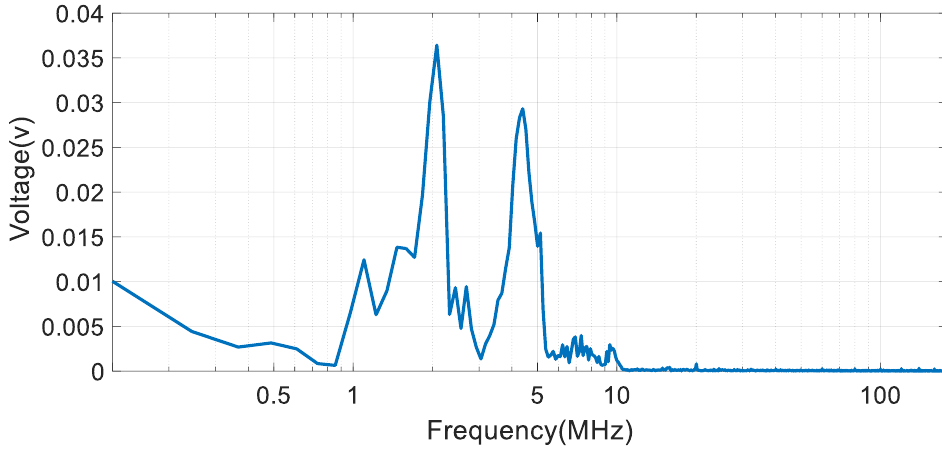
Appl. Sci. 2022 , 12 , x FOR PEER REVIEW Figure 8. Fast Fourier Transform for the PZT sensor. Figure 8. Fast Fourier Transform for the PZT sensor.